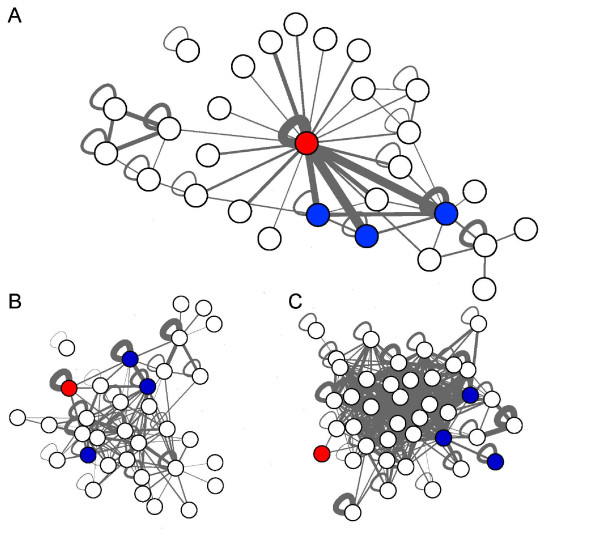
Inter-biological process exchanges over the central interactome. High-scoring fluxes between biological processes provide us with a mean to summarize the main function of the central interactome, a subset of the human interactome that is likely to be expressed in all the human cells. In our scoring scheme, high scores represent fluxes that are much more intense than expected from GO term frequencies and protein connectivity, i.e. exchanges significantly favored by protein interactions. GO biological processes are represented as nodes and scores by the edge thickness. (A) Fluxes within the central interactome. The star-like topology with translation (red) at its center shows that most exchanges synchronize other cellular processes with translation. The strongest crosstalk can be observed between translation and GO categories (blue), which contain many members of the nucleic acid metabolism (needed for mRNA generation) and complexes such as signal recognition particle, coatomer protein complex and the splicosome. (B) Fluxes between C.Prot proteins and proteins not in C.Prot. As soon as the focus shifts away from the central interactome, translation loses its role as central communicator. Communication between C.Prot and non C.Prot are less specialized. Also, note the lost interconnectivity of the blue cluster, which reflects reduced activity of the processes mentioned above. (C) This trend is further amplified in the external fluxes between proteins not in C.Prot that become essentially global and ignore translation.